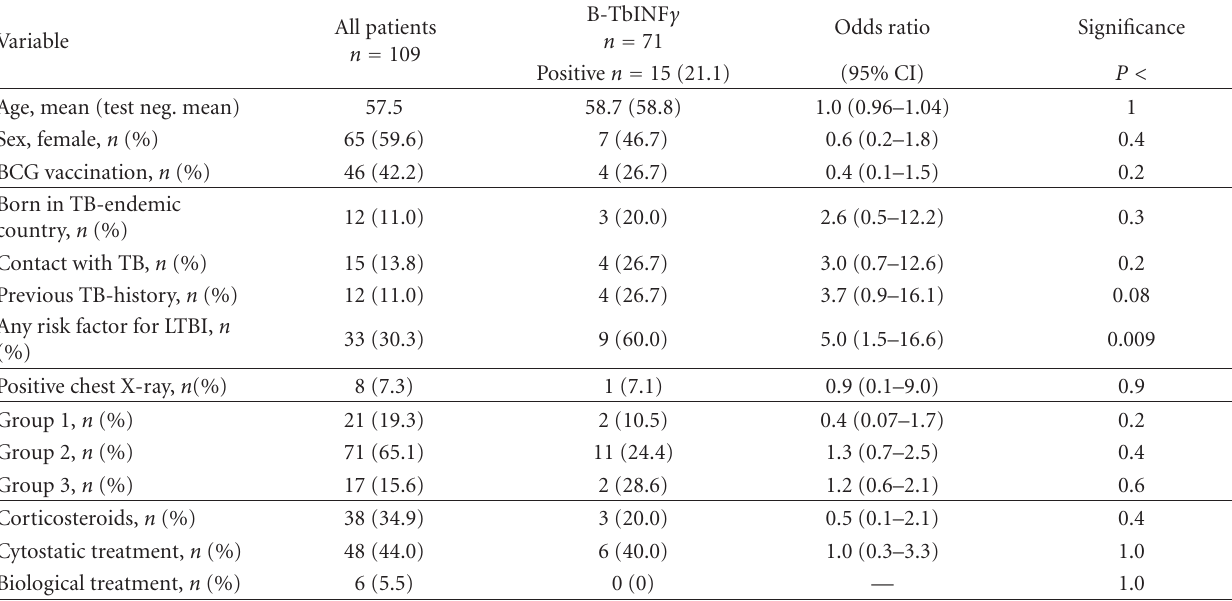
Table 4: The univariate analysis of the TB risk factors with a positive outcome of the B-TbIFNg test. Variable